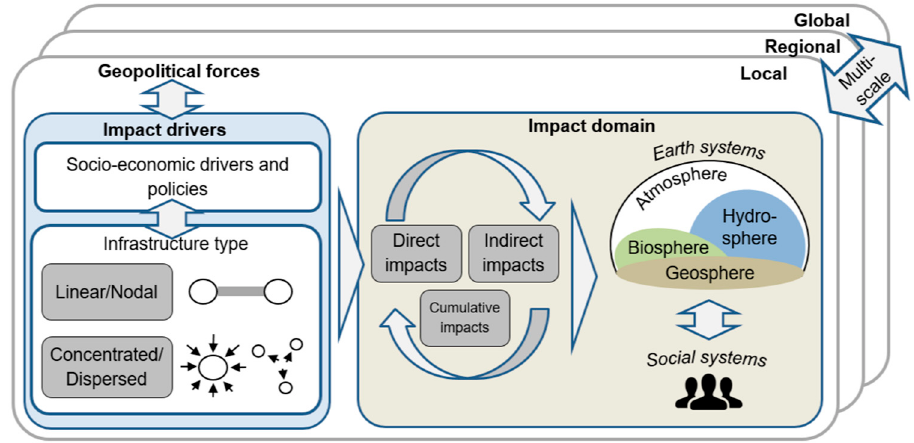
Figure 1. Multi-scale, socio-economic-political and environmental framework for planning and addressing the impacts of BRI.